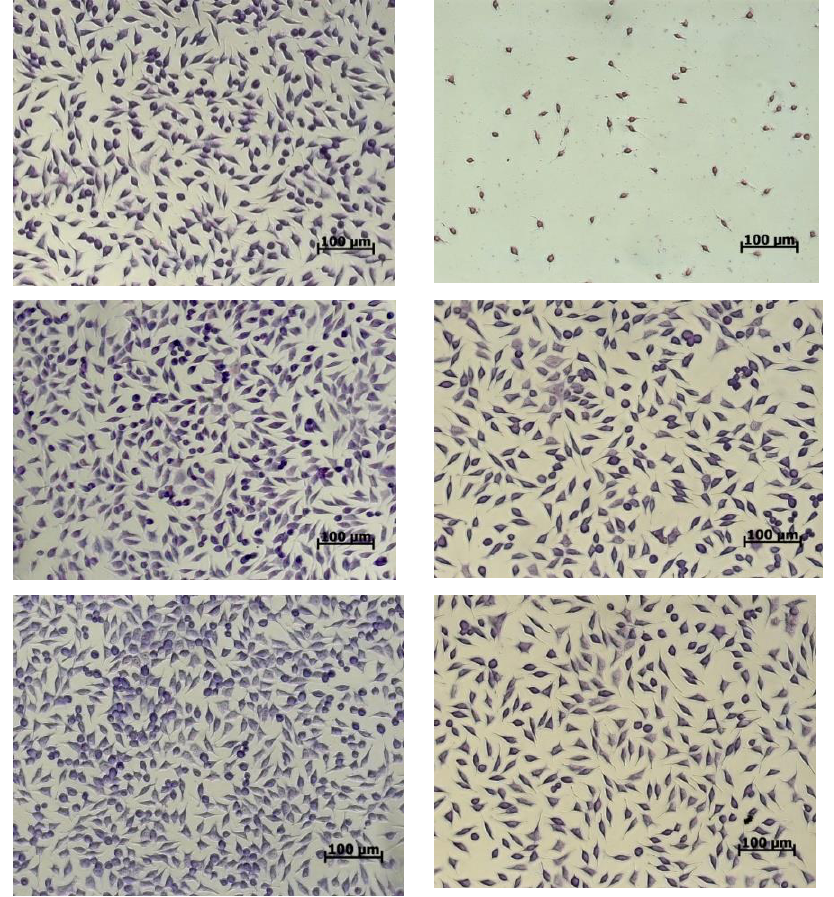
Figure 4. Light micrographs of L929 cells treated with microencapsulated variants of yellow onion skin extracts for 48 h.